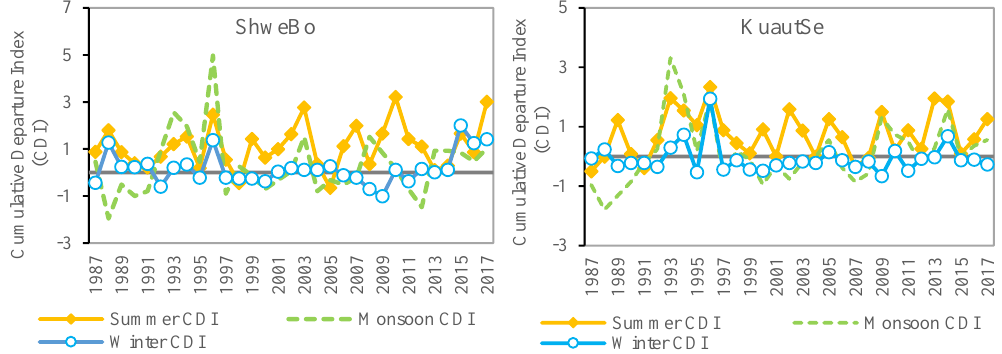
Figure 7. Season temperature fluctuation based on cumulative departure index (CDI) between 1987 and 2017.